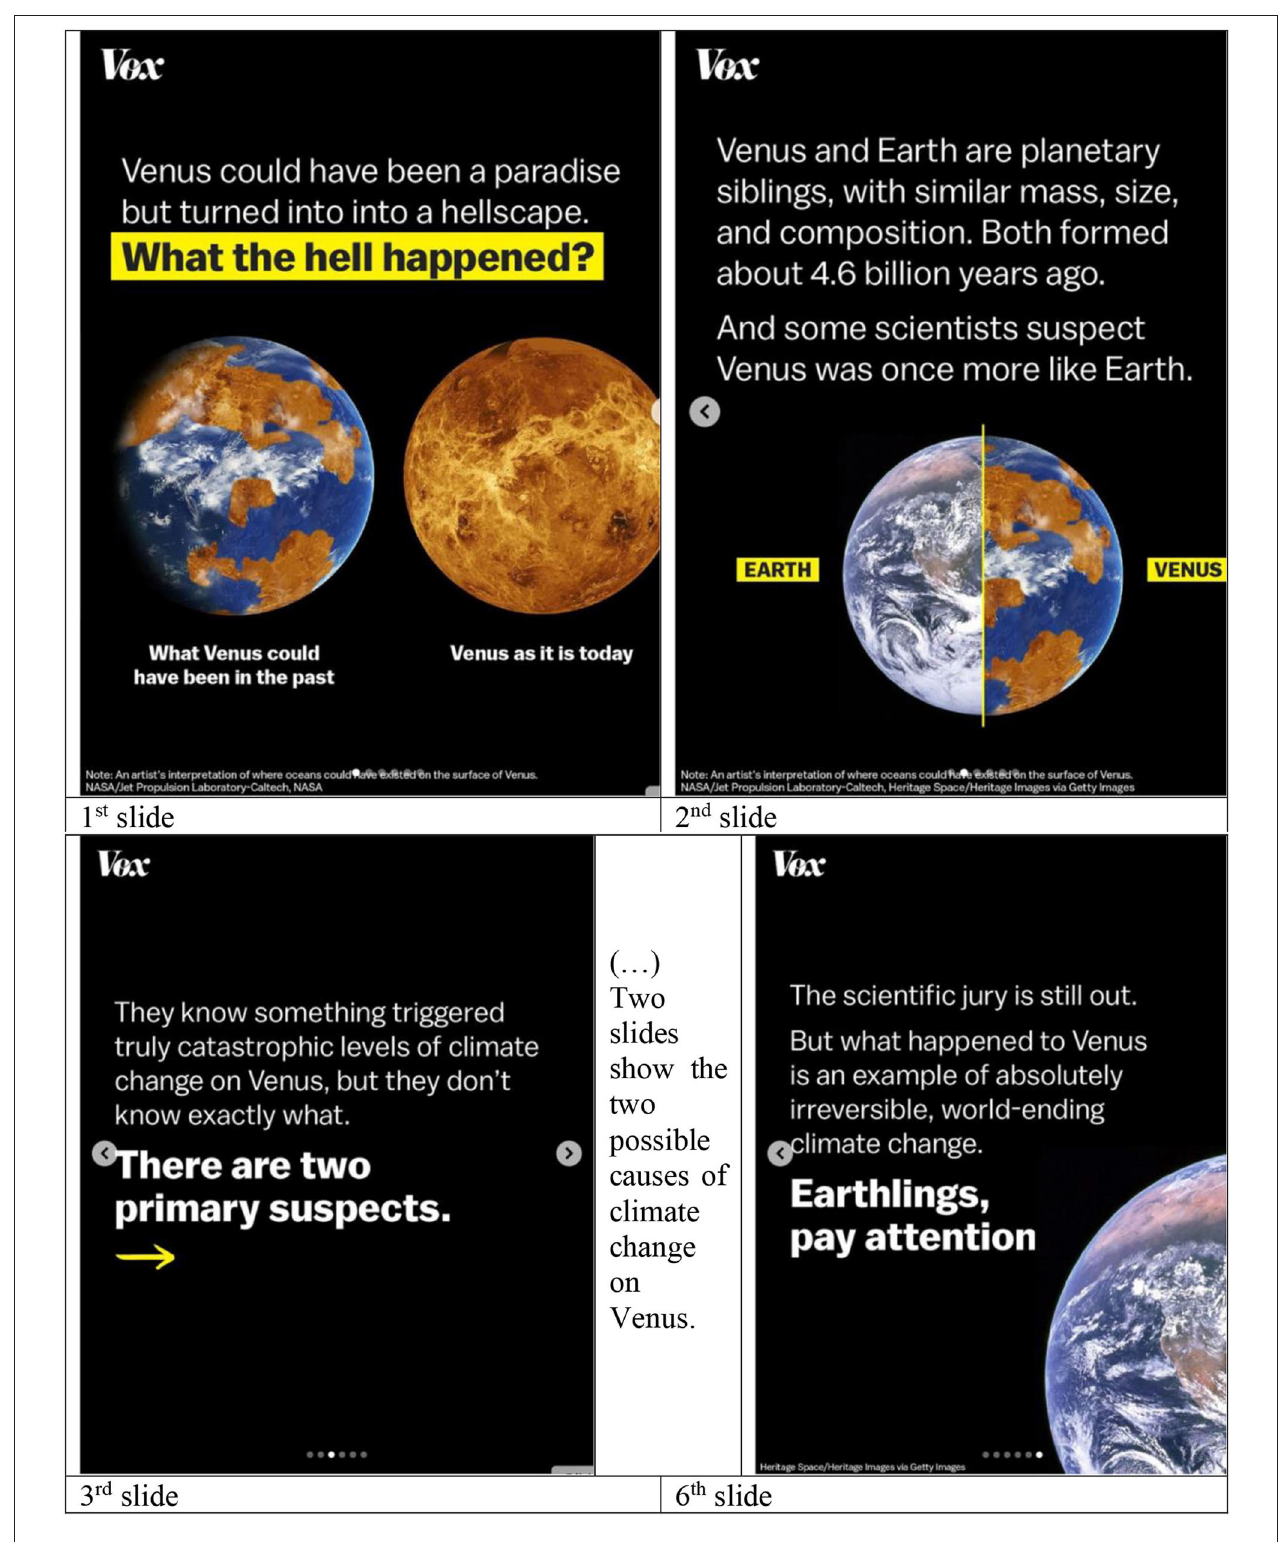
FIGURE 2 | Vox (2022) (https://www.instagram.com/p/CXUf4iOu28U/, accessed March 20, 2022).